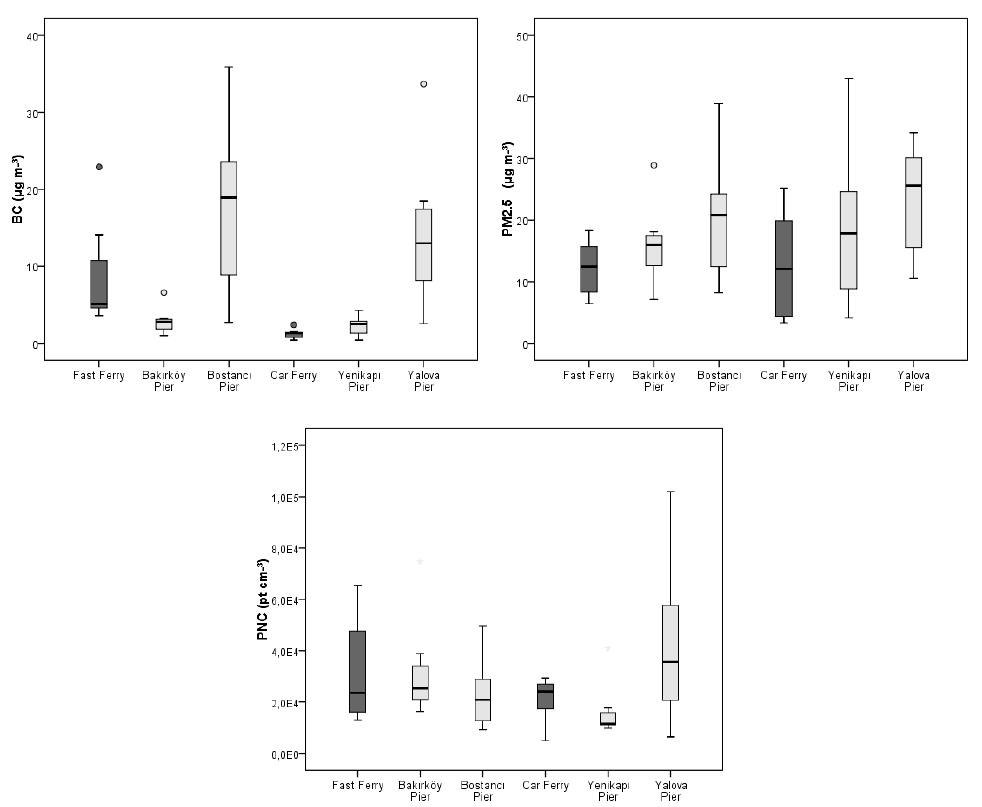
Figure 2. Boxplot of mean BC, PM 2.5 , and PNC concentrations for in-ferry and at the pier. The boxes represent the interquartile range (25th to 75th percentile), whiskers represent 10th and 90th percentile, and the middle lines represent the mean values, the circles represent the